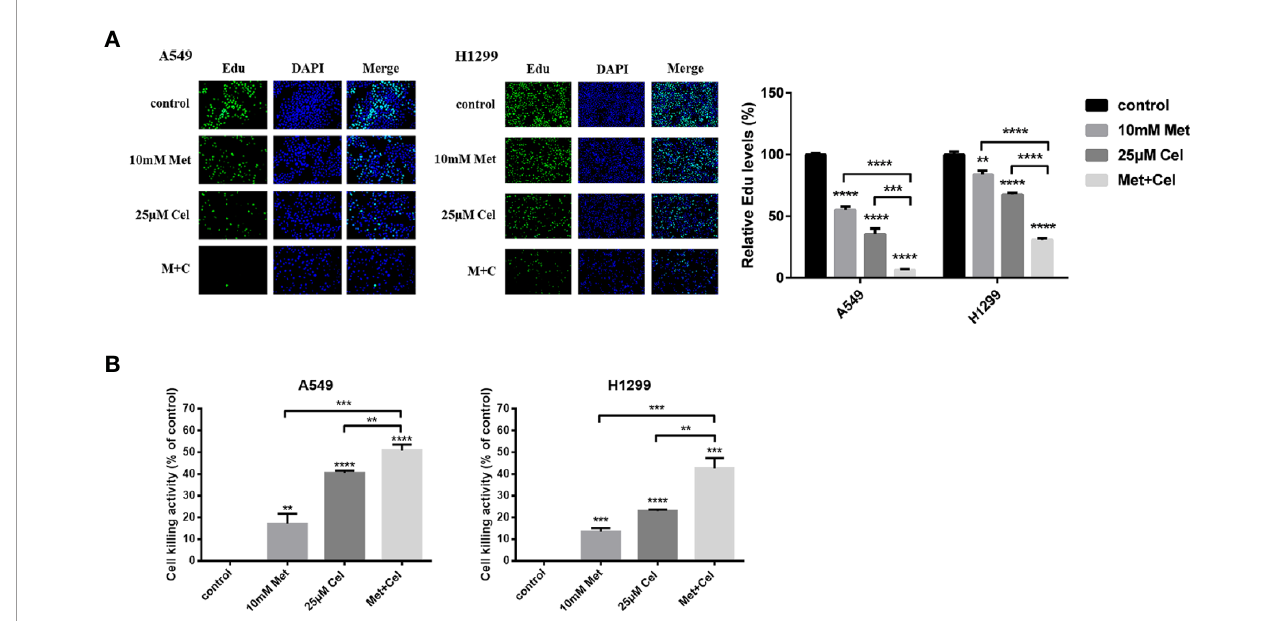
FIGURE 2 | Effect of celecoxib and metformin on the growth of NSCLC cells in vitro . (A) Detection of DNA proliferation rate in A549 and H1299 cells treated with 10 mM metformin and/or 25 m M celecoxib by Edu. (B) Detection of cytotoxicity of A549 and H1299 cells treated with10 mM metformin and/or 25 m M celecoxib by LDH. Data are represented as mean ± SD. ** p < 0.01, *** p < 0.001, **** p <